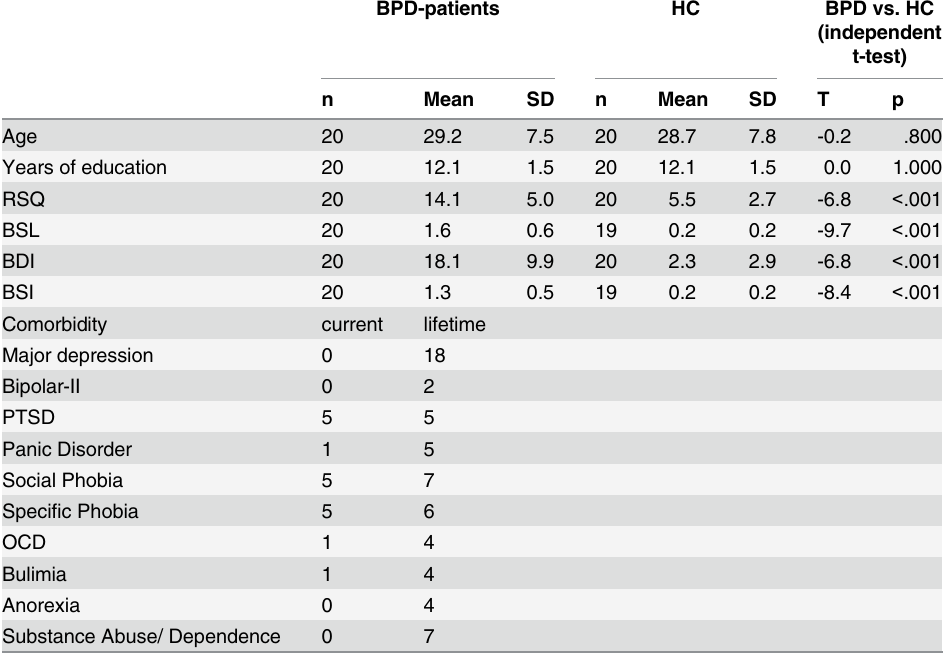
Table 1. Demographic and clinical variables in patients with borderline personality disorder (BPD) and in healthy controls (HC) with results of the t-tests (independent, two-tailed).